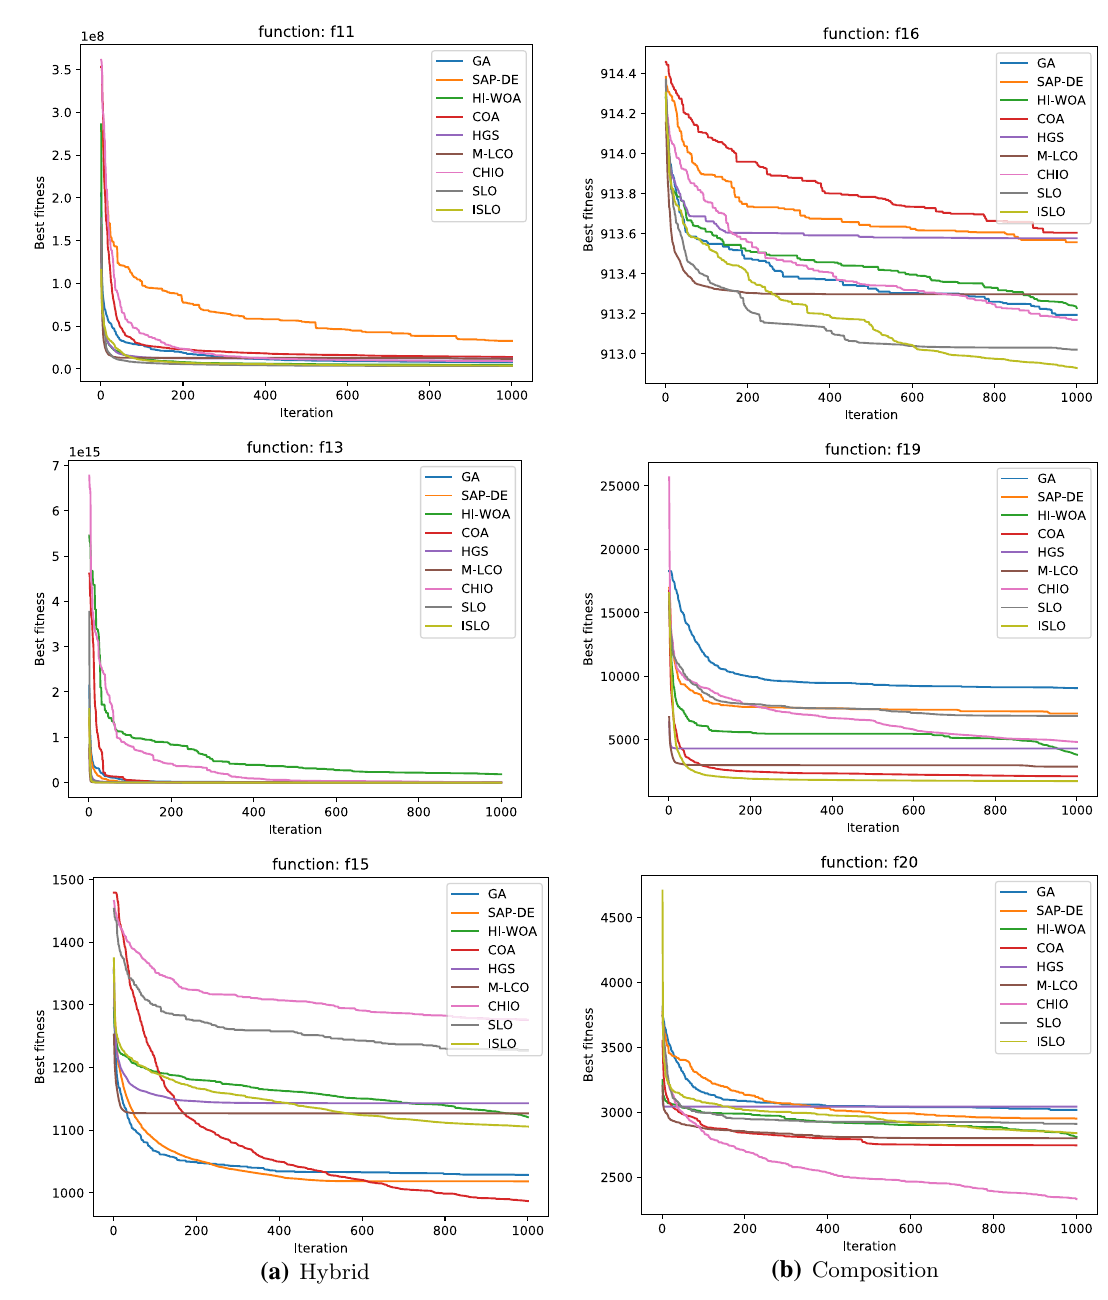
Fig. 7 Convergence speed of each algorithm on hybrid ( a -left side) and composition ( b -right side)